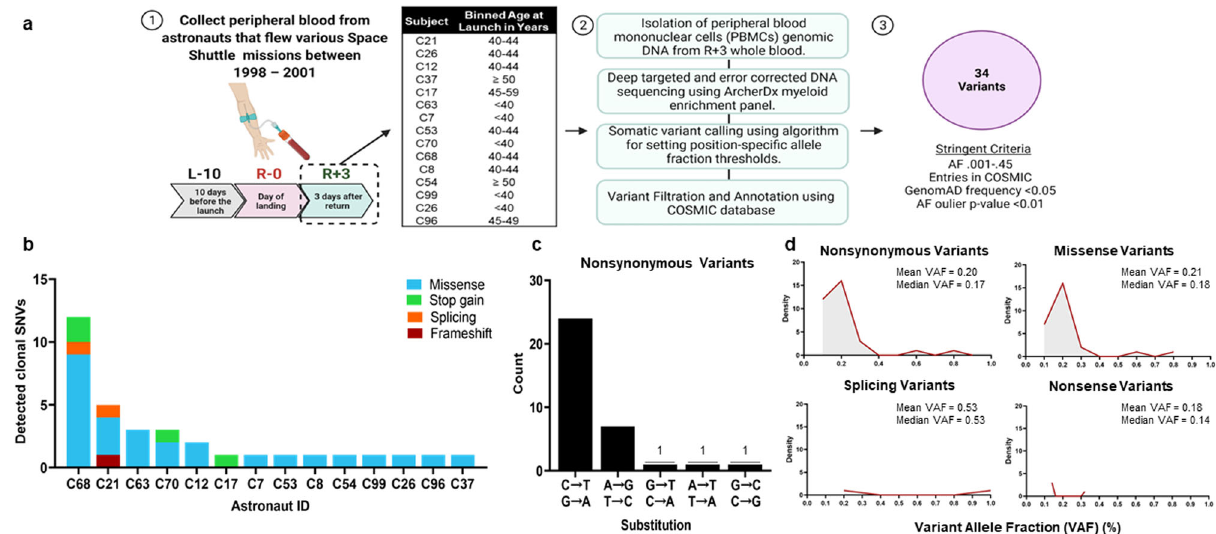
Fig. 1 Characteristics of Clonal Hematopoiesis (CH) Mutations. a We identi fi ed somatic mutations in known clonal hematopoiesis of indeterminate potential (CHIP) driver genes using peripheral blood mononuclear cells isolated from 14 astronauts who fl ew short space Shuttle missions lasting a median of 12 days between 1998 – 2001. Created with BioRender.com. b Number of somatic nonsynonymous single nucleotide variants (SNVs) in CHIP-driver genes harbored per subject. c Rates of different substitution types observed in clonal SNVs. Only one guanine to thymine transition was observed. d Density of mutations by VAF for each mutation